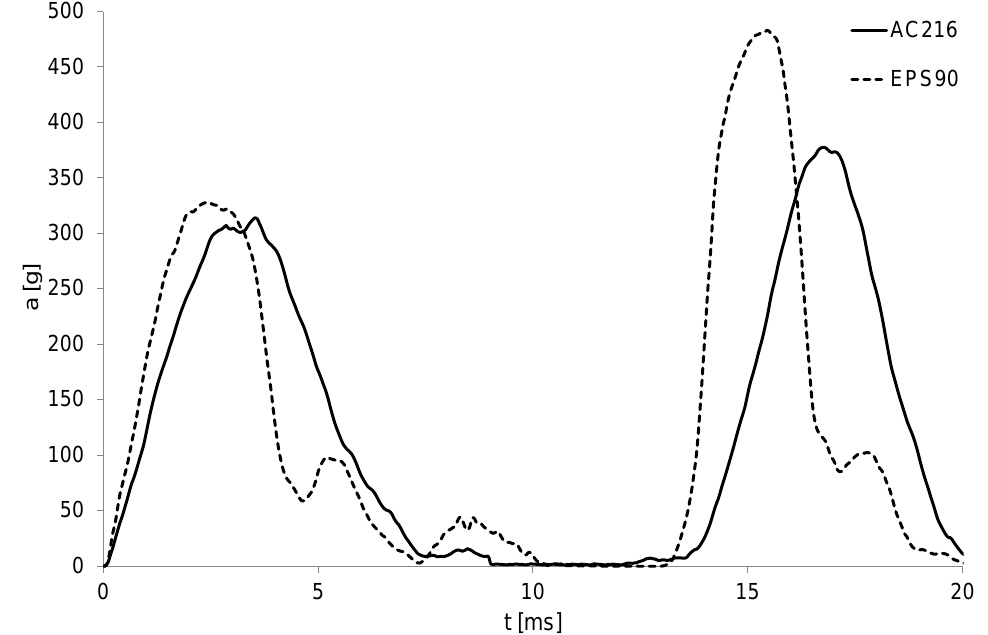
Figure 11. Acceleration-time history of 40 mm thick helmets subjected to double impacts.